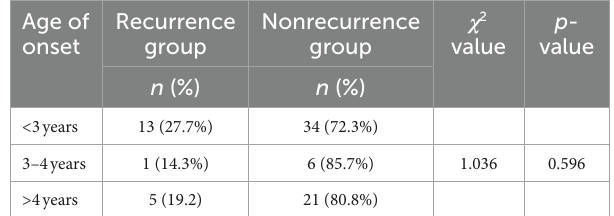
TABLE 3 Comparison of age of onset between the two